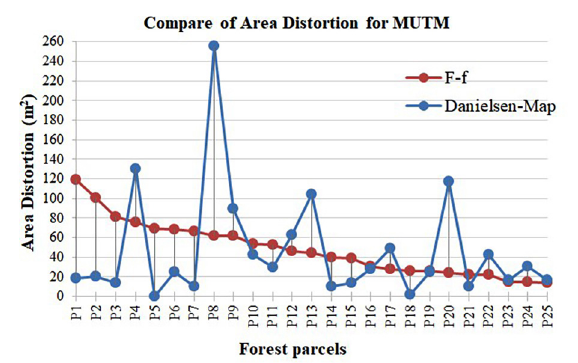
Figure 3. Comparison of the area distortion for